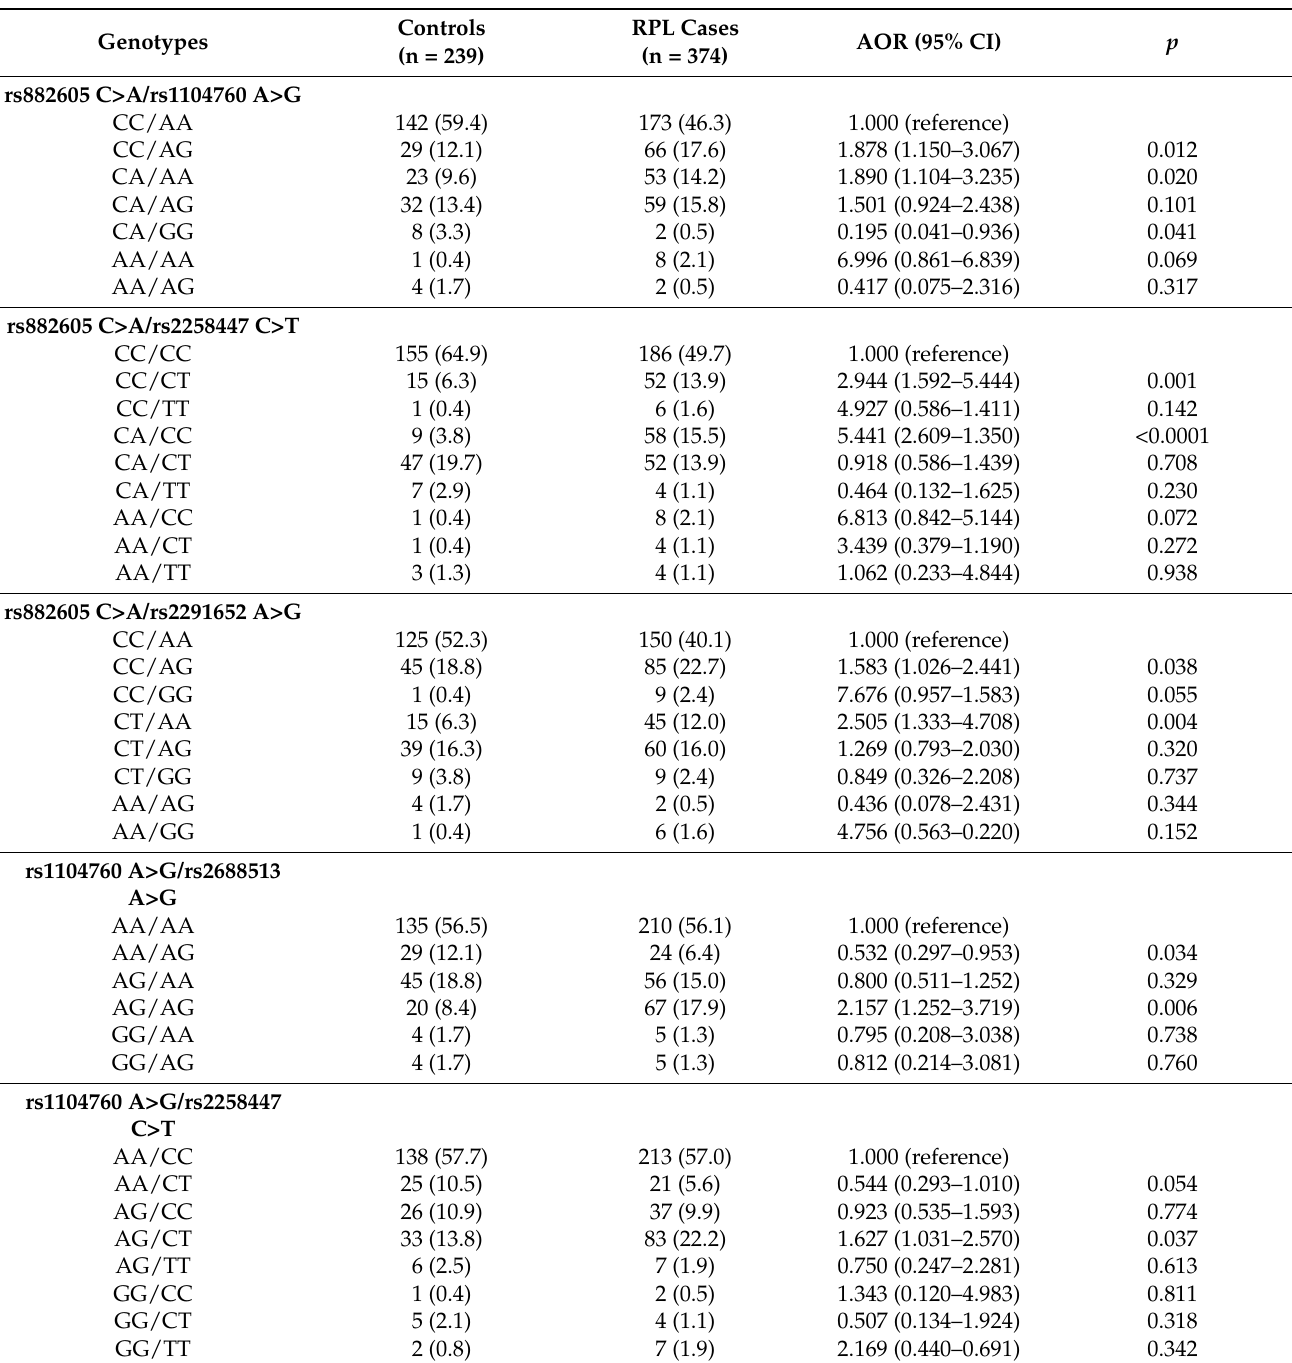
Table 4. The combination analysis of the MUC4 polymorphisms between the RPL patients and the control